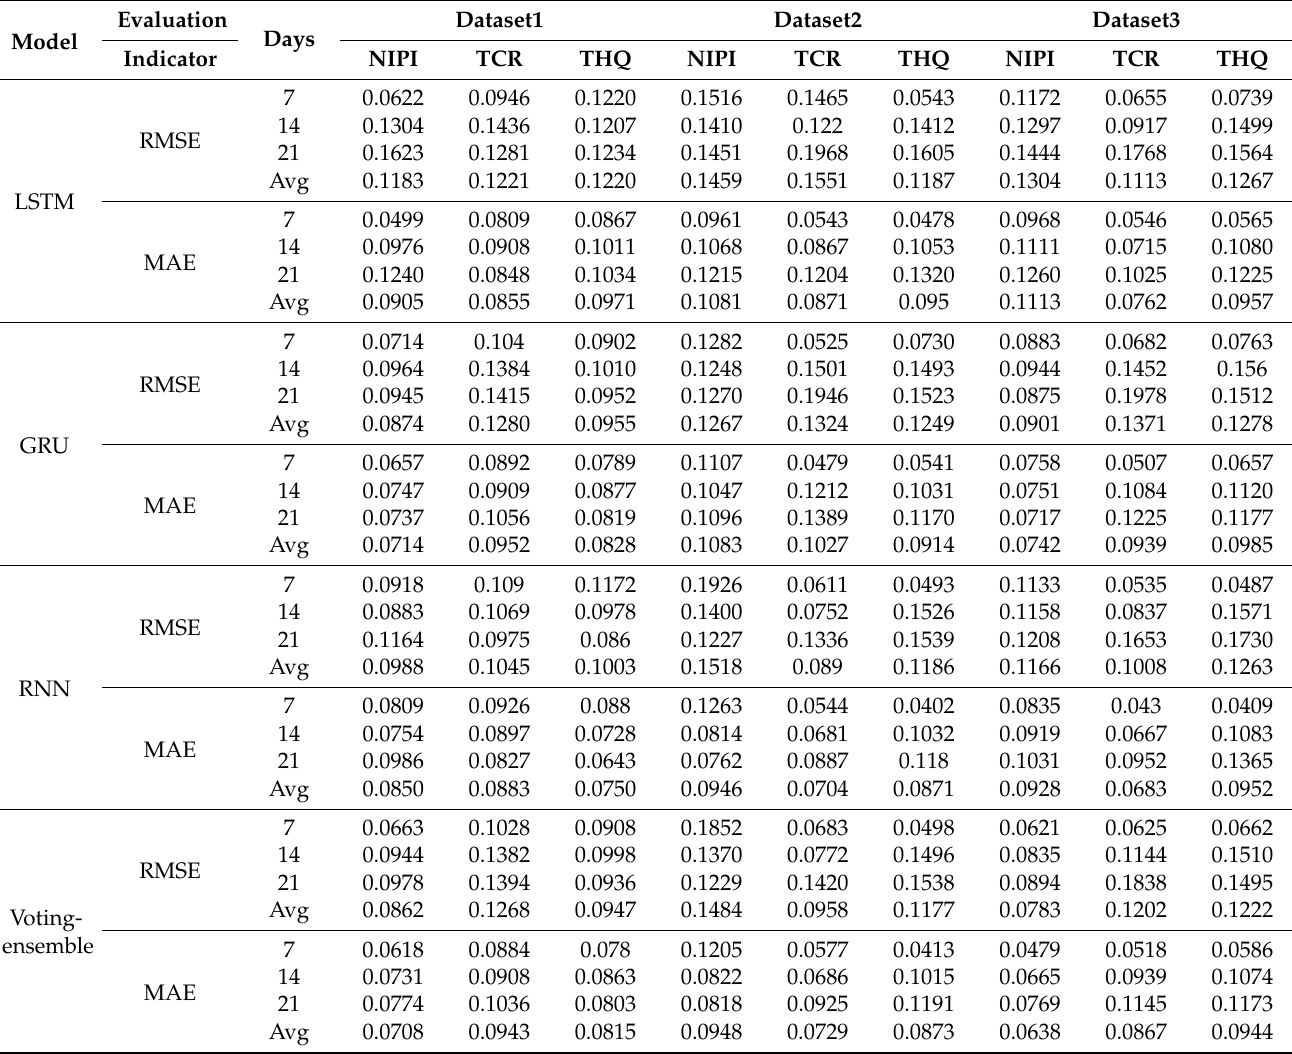
Table 6. Performance of LSTM, GRU, RNN, and the voting-ensemble method (21